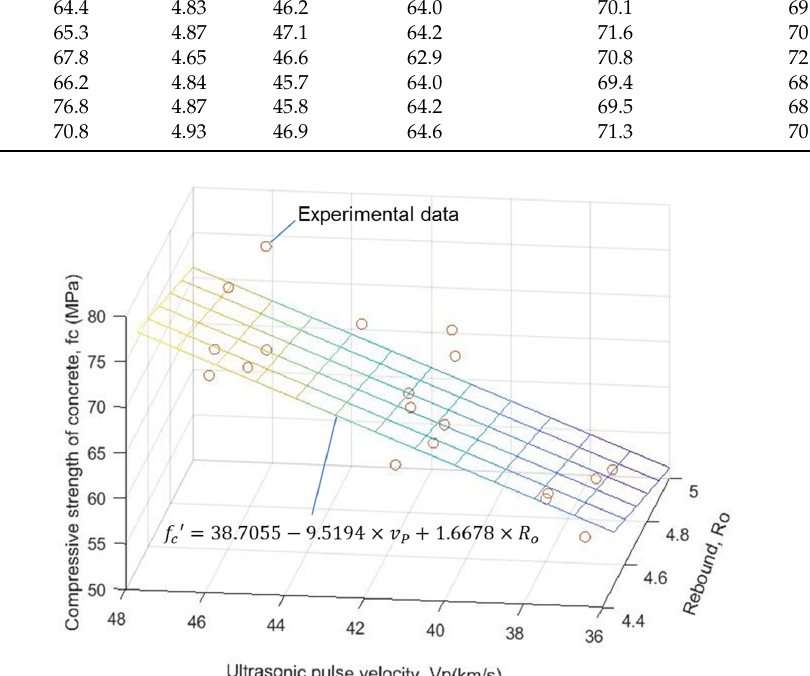
Figure 4. Relationship between tested compressive strength of concrete cylinder and predicted by the non ‐ destructive test.